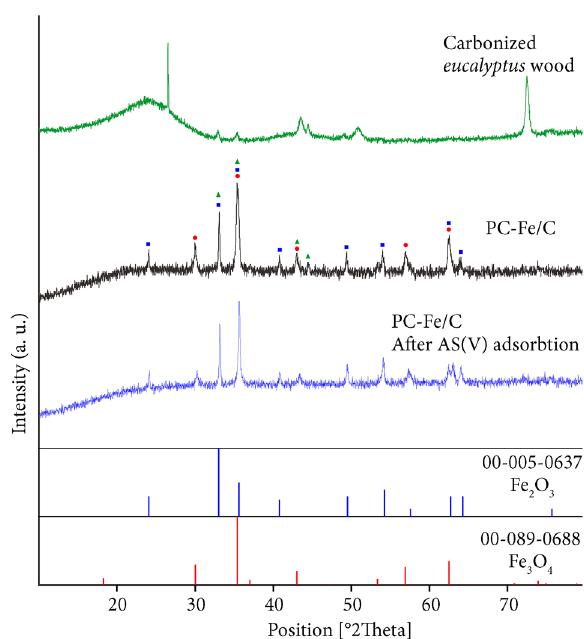
Figure 2. FT-IR spectra of the PC-Fe/C adsorbent prepared with eucalyptus wood